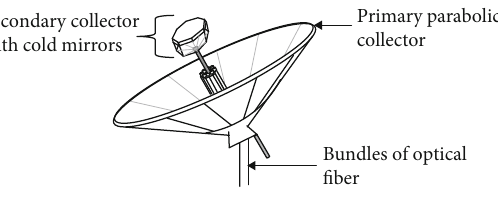
Figure 6: Hybrid lighting prototype showing the secondary collector with eight faceted cold mirrors (source: adapted from